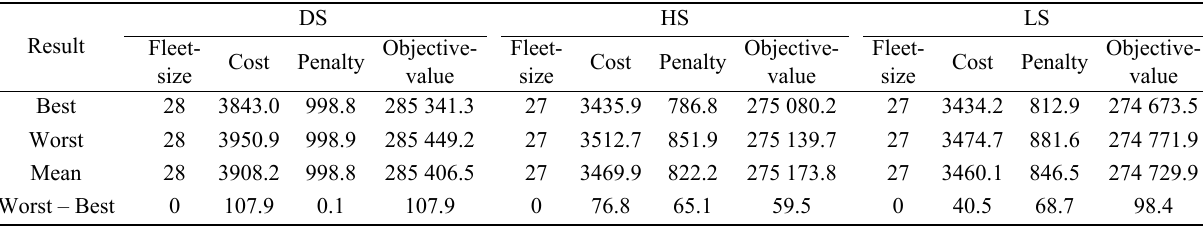
Table 8 Results of 20 runs for DABC with 3 search